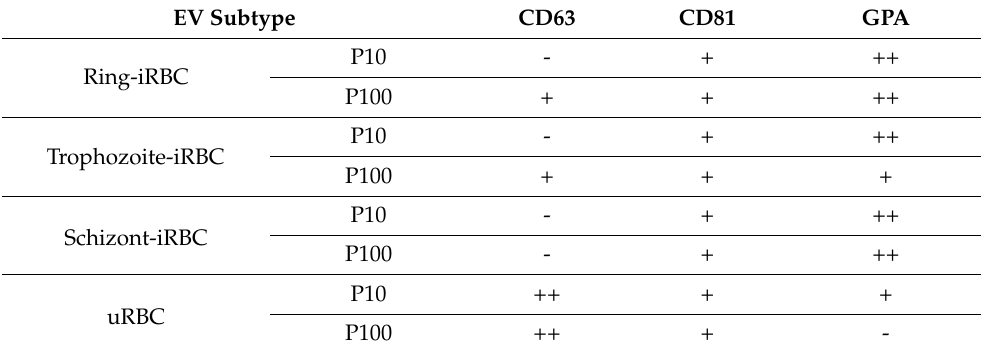
Table 1. Summary of protein profile of malaria-derived EVs defined by the presence or absence of EV